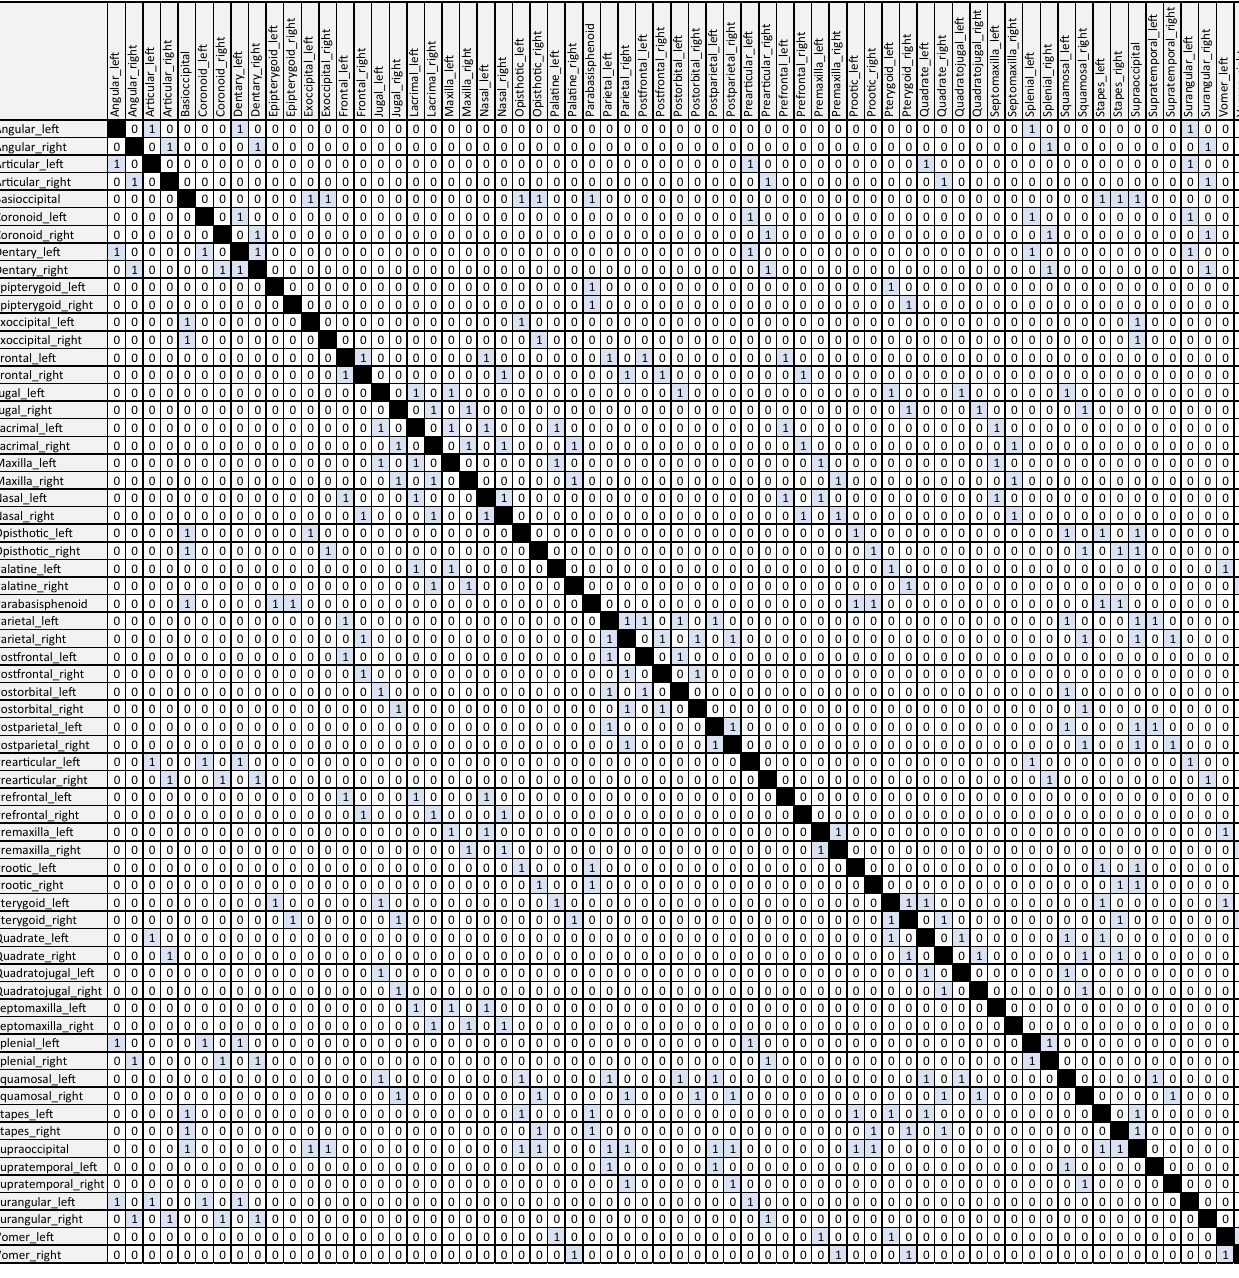
TABLE 1 | Anatomical network matrix of the skull of † Captorhinus aguti . Connections (i.e., “1”) are highlighted in blue. Please note that cells representing contacts between identical nodes (e.g., “Angular_left” vs. “Angular_left”) are filled black for reading aid. For the analysis, such cells have to be coded as “0”. Alterations of this matrix based on Figures 1A,C as well as related CSV-files can be found in the accompanying Supplementary Material